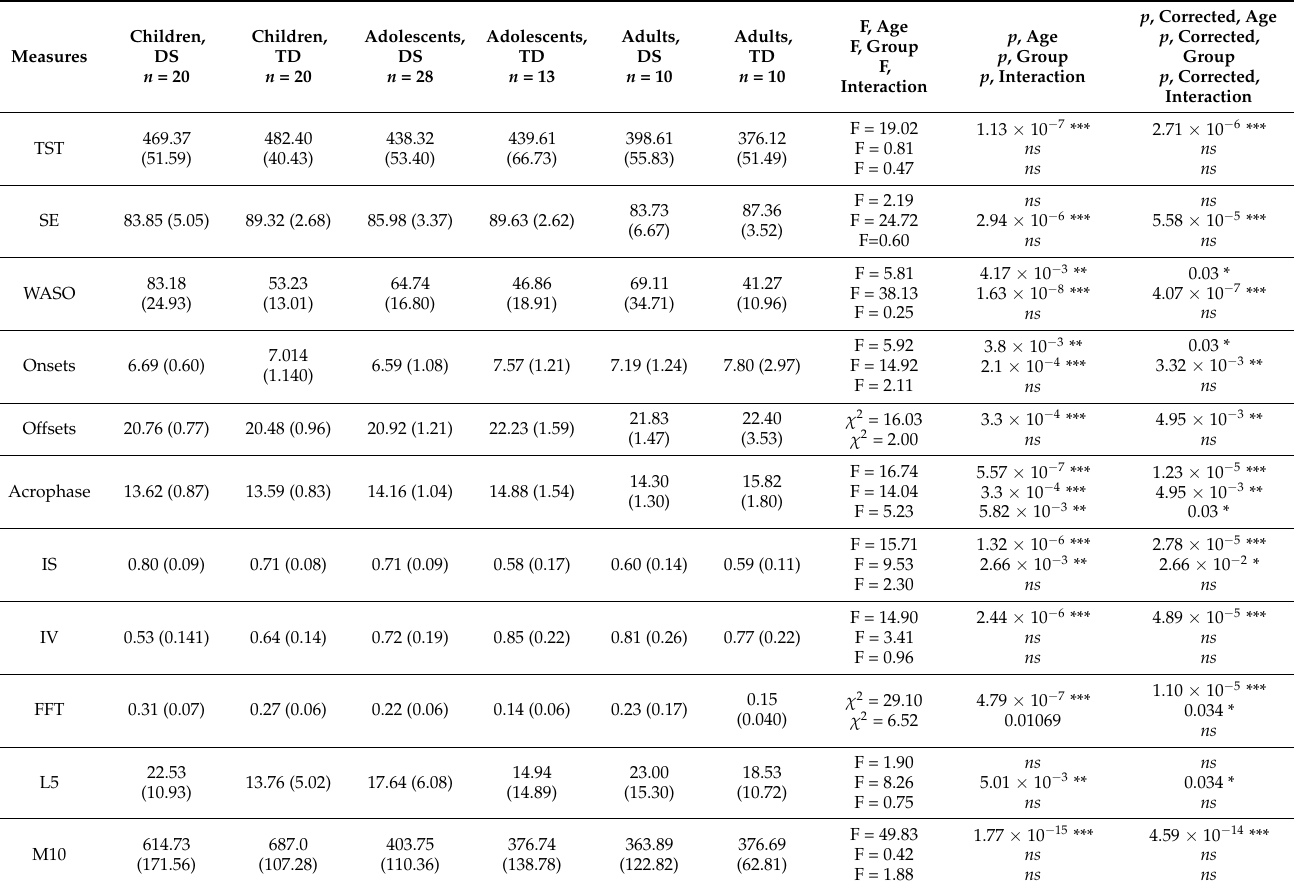
Table 2. ANOVA results for sleep, phase, and circadian markers; M (SD) grouped by individuals with DS and with TD over 3 age groups: children 6–10, adolescents 11–18, and young adults 19–26.